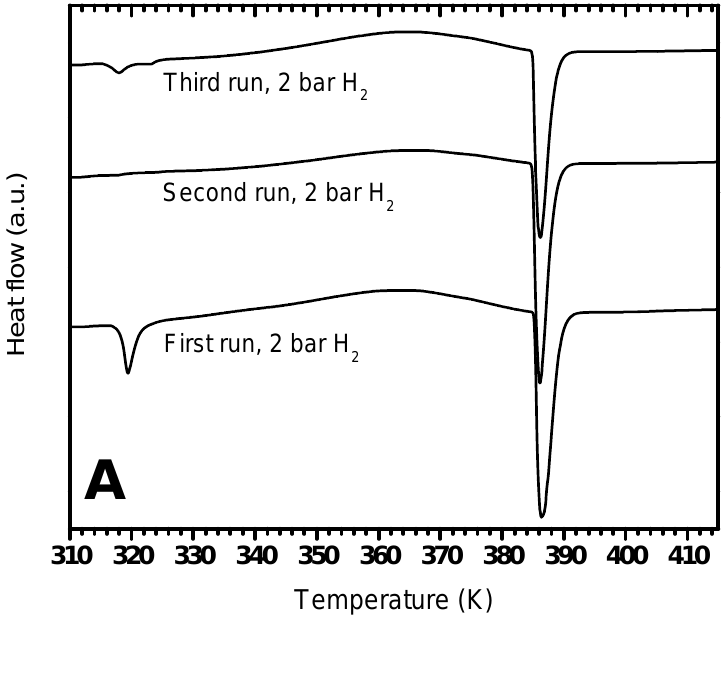
. (A): All runs performed 4